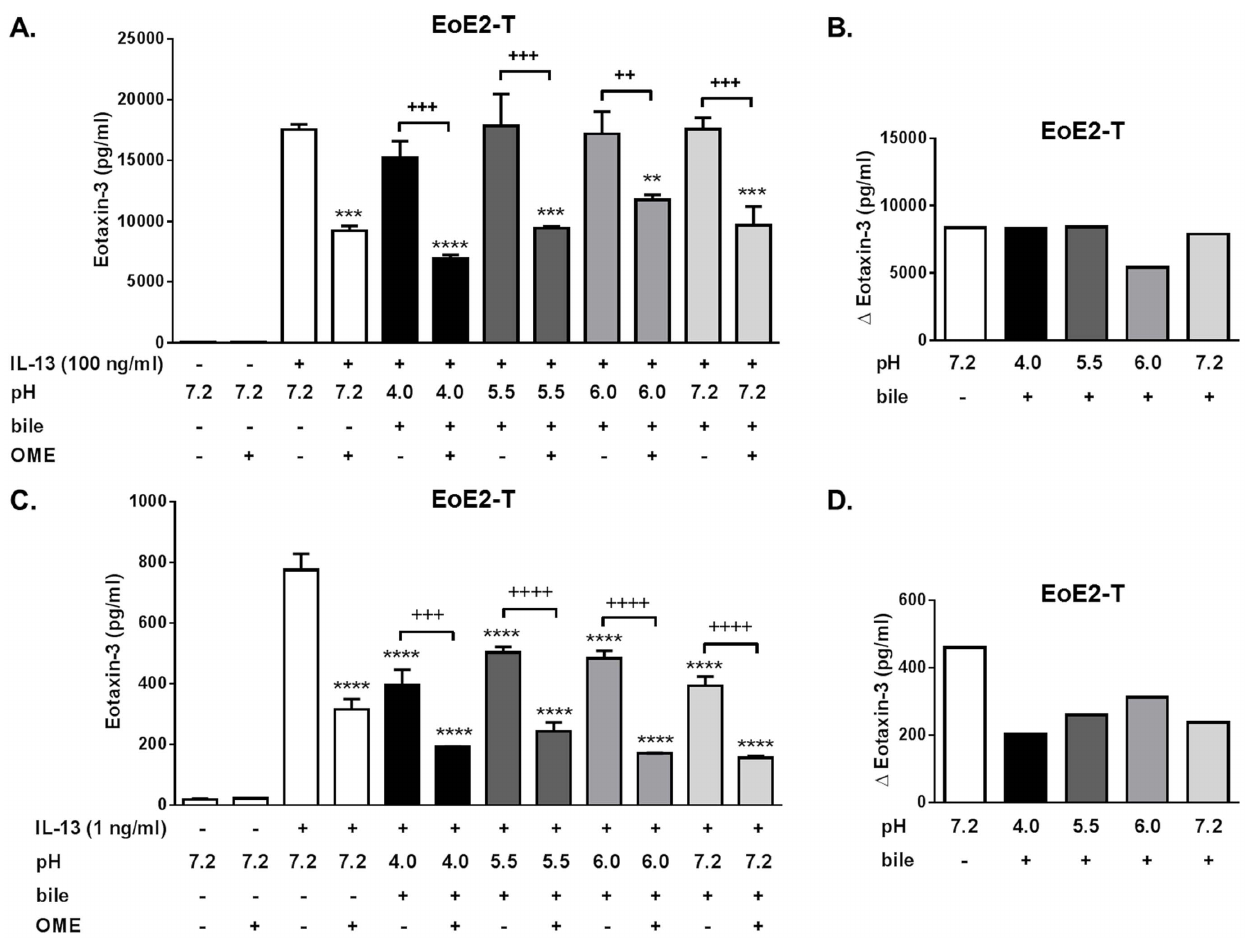
Figure 7. Acid and bile salt effects and PPI anti-inflammatory effects on IL-13-induced eotaxin-3 protein secretion in EoE2-T cells. (A) Combined effects of acid-bile salt medium and omeprazole (OME) on eotaxin-3 protein secretion in EoE2-T cells stimulated with 100 ng/ml of IL- 13. Data are mean 6 SEM of 2 experiments. **P , 0.01, ***P , 0.001, and ****P , 0.0001 compared to IL-13 alone (pH 7.2, no bile, no OME). ++ P , 0.01 and +++ P , 0.001. (B) Graph depicts the magnitude of the decrease in IL-13-stimulated eotaxin-3 secretion achieved by omeprazole for each acid-bile salt exposure condition in Figure 7A. (C) Combined effects of acid-bile salt medium and omeprazole on eotaxin-3 protein secretion in EoE2-T cells stimulated with 1 ng/ml of IL-13. Data are mean 6 SEM of 2 experiments. ****P , 0.0001 compared to IL-13 alone (pH 7.2, no bile, no OME). ++ P , 0.01 and +++ P , 0.001. (D) Graph depicts the magnitude of the decrease in IL-13-stimulated eotaxin-3 secretion achieved by omeprazole for each acid-bile salt exposure condition in Figure